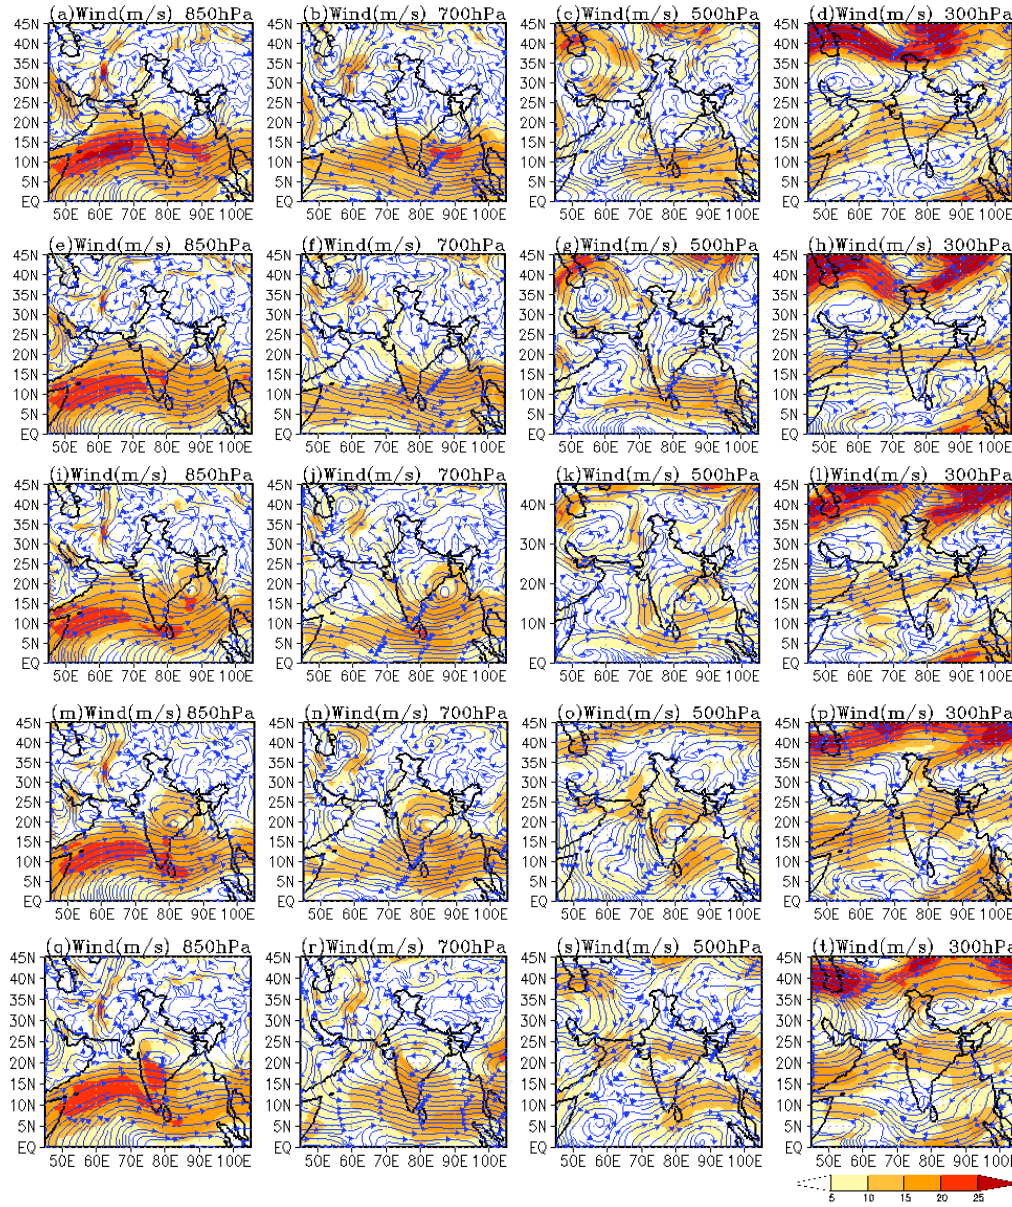
Figure 3. Wind speed (shaded; ms − 1 ) and direction at ( a ) 850, ( b ) 700, ( c ) 500, and ( d ) 300 hPa levels valid at 00 UTC on ( a ) 13 August, 2018; similarly, ( e – h , i – l , m – p and q – t ) present the 14, 15, 16, and 17 August 2018 data derived from ERA-Interim reanalysis at 25 km resolutions.